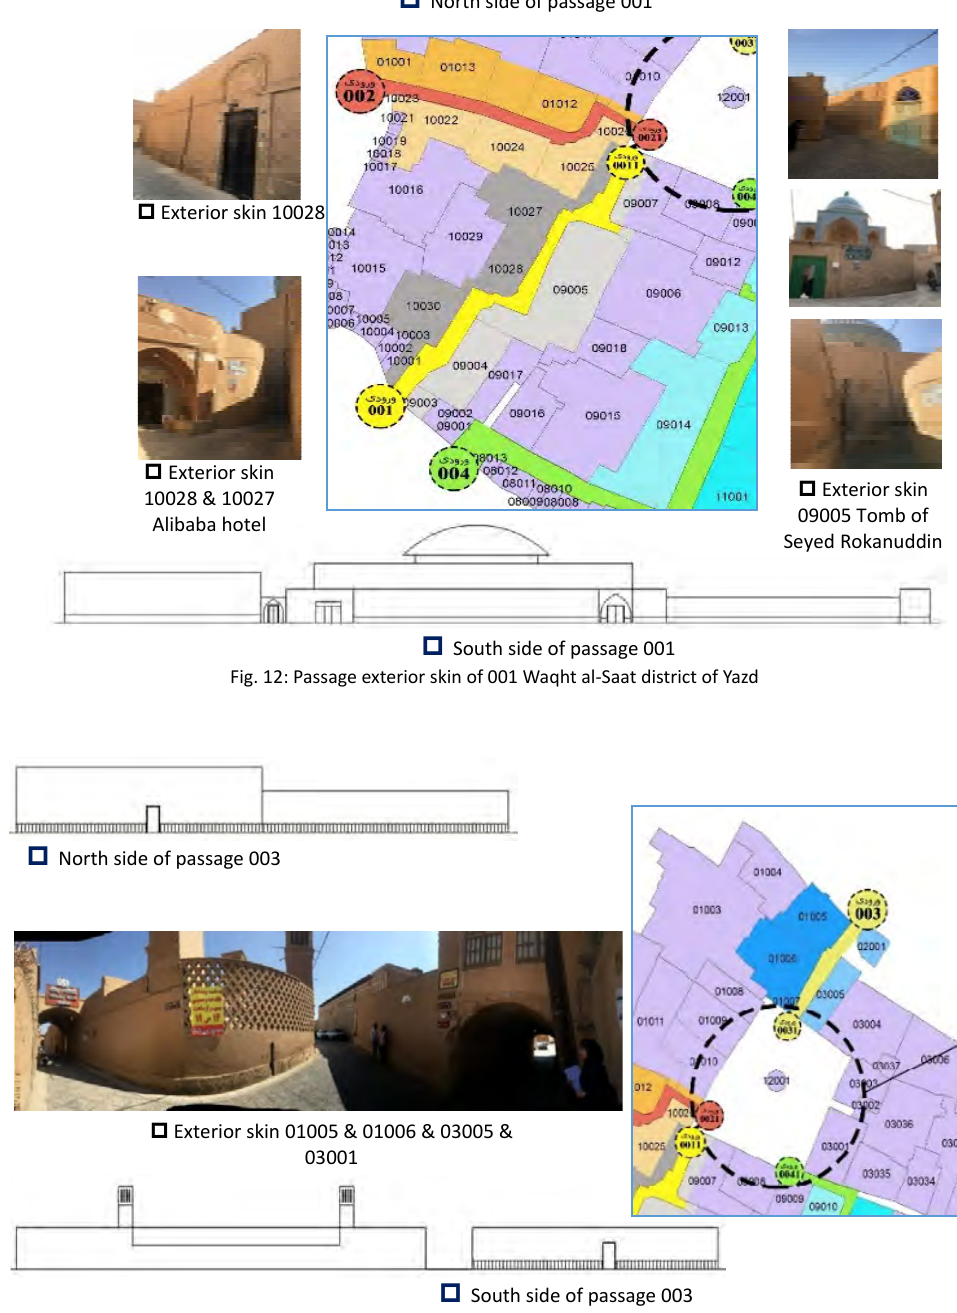
Fig. 13: Passage exterior skin of 003 Waqht al-Saat district of Yazd